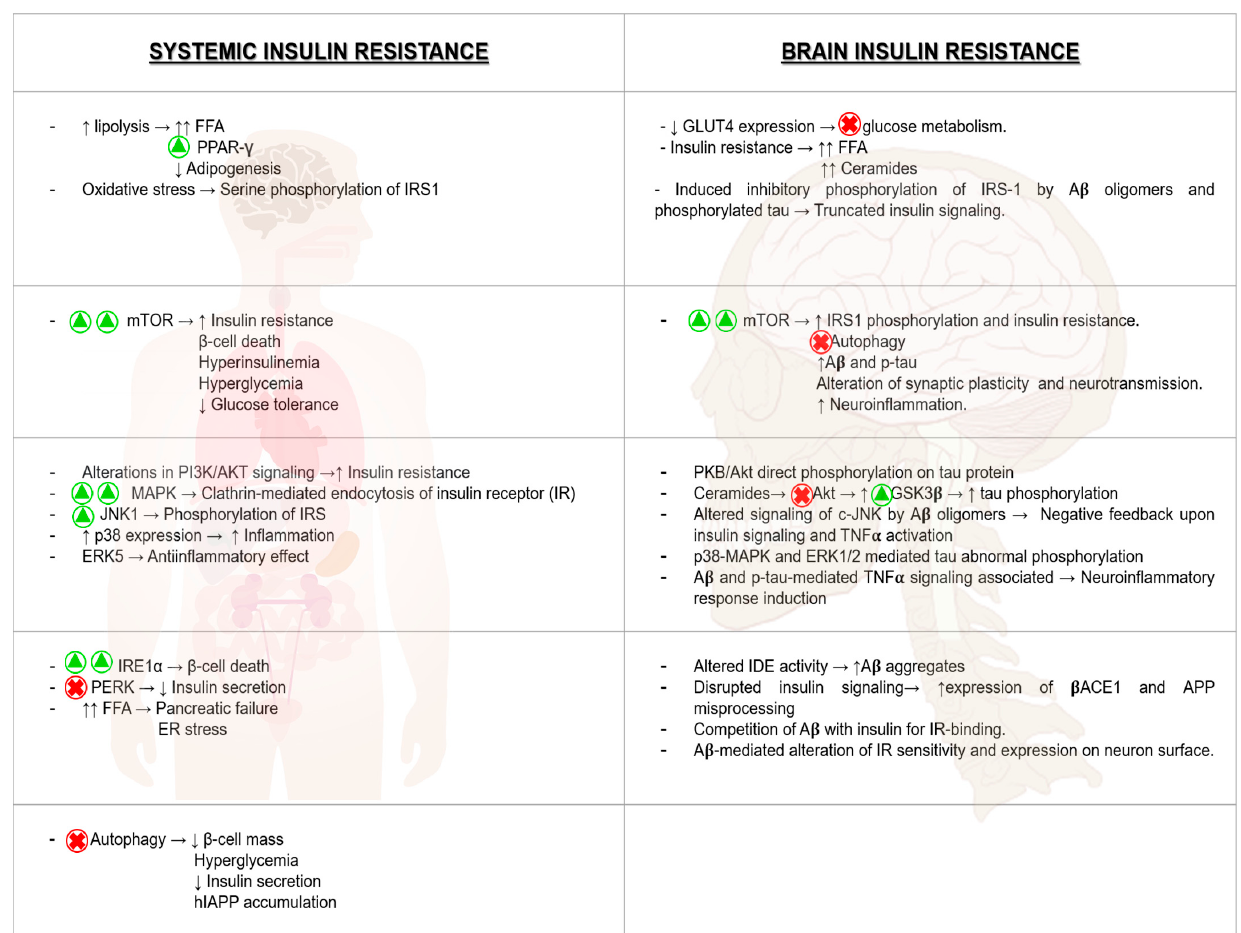
Figure 3. Molecular mechanisms of both systemic and brain insulin resistance and their consequences.